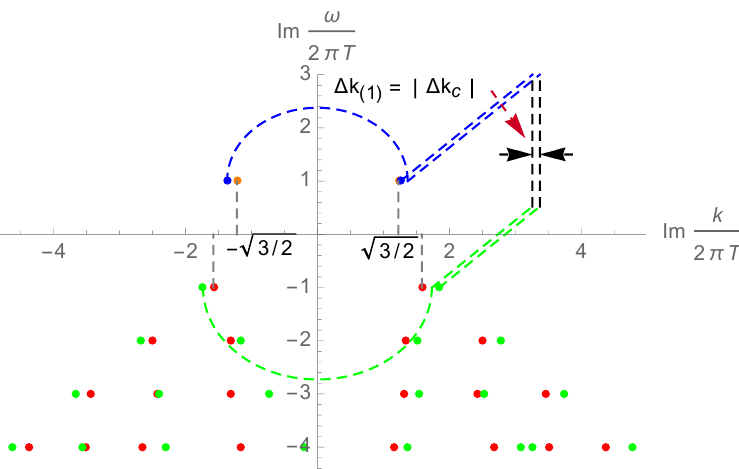
Figure 2 . Spectrum of chaos points (in the upper half plane) together with the pole-skipping points of a boundary operator dual to a scalar (cid:12)led with mass m = 2 in the bulk (in the lower half plane). Orange and red points are related to non-chiral matter at (cid:23) = 0 and b = 0. Blue and green points correspond to a chiral matter at (cid:23) = 0 : 5 and b = 0 : 5. Orange and red points are symmetric with respect to the Im ! -axis, however, due to the chiral anomaly, the blue and Green ones are located asymmetrically with respect to the same axis.